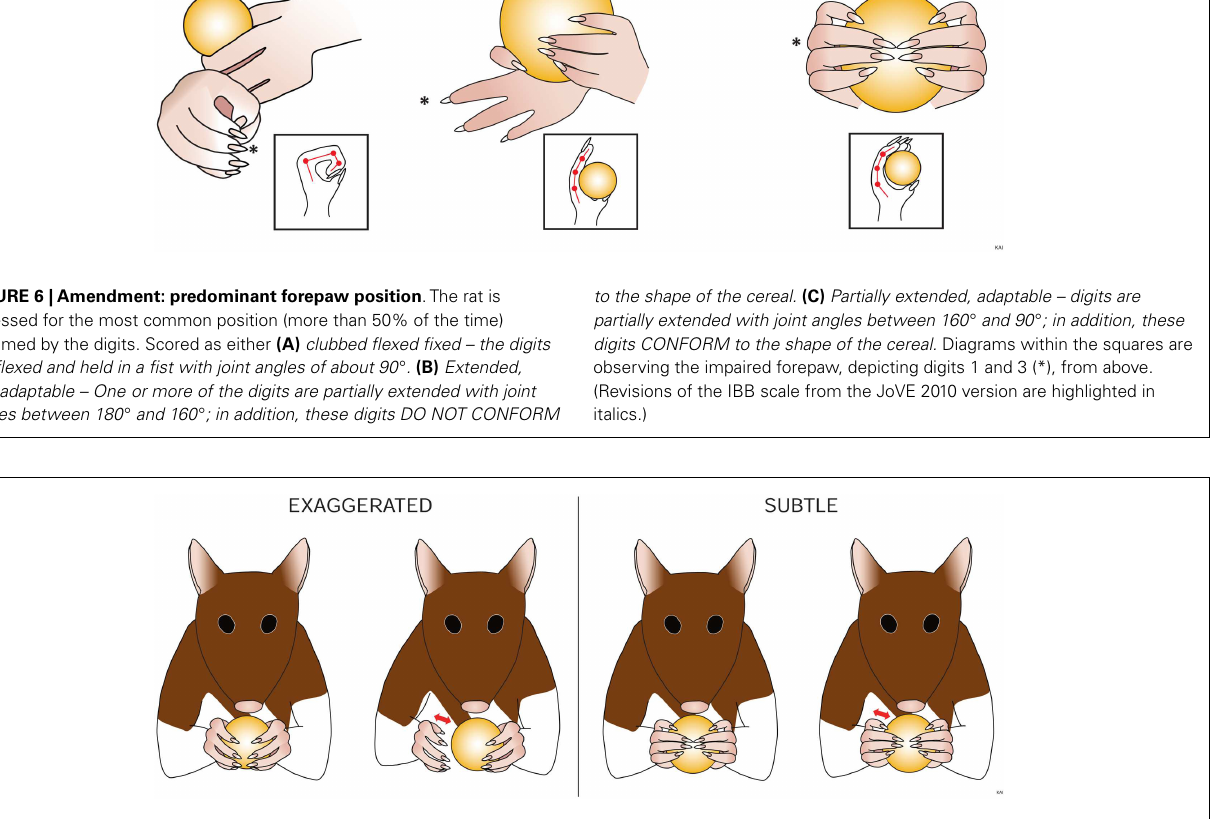
manipulation of the cereal by the volar surface of the forepaws. Subtle – movements by the shoulder, and/or elbow, and/or wrist of the impaired forelimb that may or may not momentarily cause a loss of contact between the volar surface of the impaired forepaw and the cereal, which DO adjust (control) the cereal position or DO contribute to the proper manipulation of the cereal by the volar surface of the forepaws. [If animals show both exaggerated and subtle proximal forelimb movements during eating, they are scored as having exaggerated movements, as these disappear with further recovery.] (Revisions of the IBB scale from the JoVE 2010 version are highlighted in